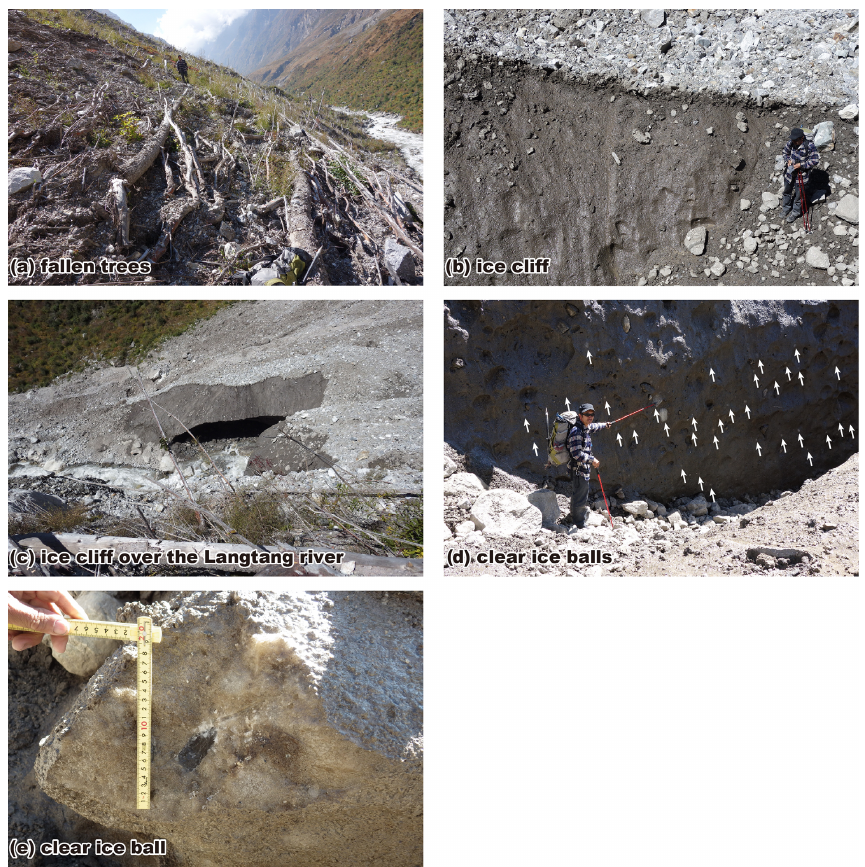
Figure 8. In situ photographs of (a) fallen trees, (b) boundary between ice and debris mantle at ice cliff, (c) rock absence in ice cliff over Langtang River, (d) “clear ice balls” contained in “dirty ice” pointed by white arrows, and (e) a close-up of clear ice ball. Locations of the tree investigation and ice cliffs are shown in Fig. 2a.